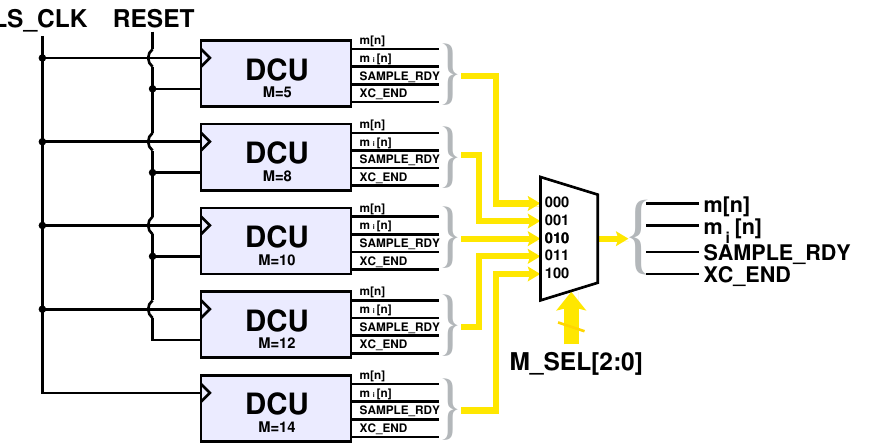
Figure 9. Circuit schematic of the implemented selectable